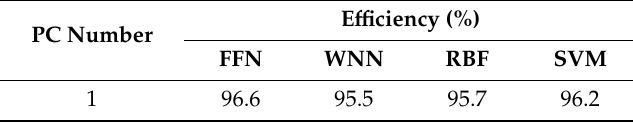
Table 3. Classification e ffi ciency test results for variable data block lengths. PC